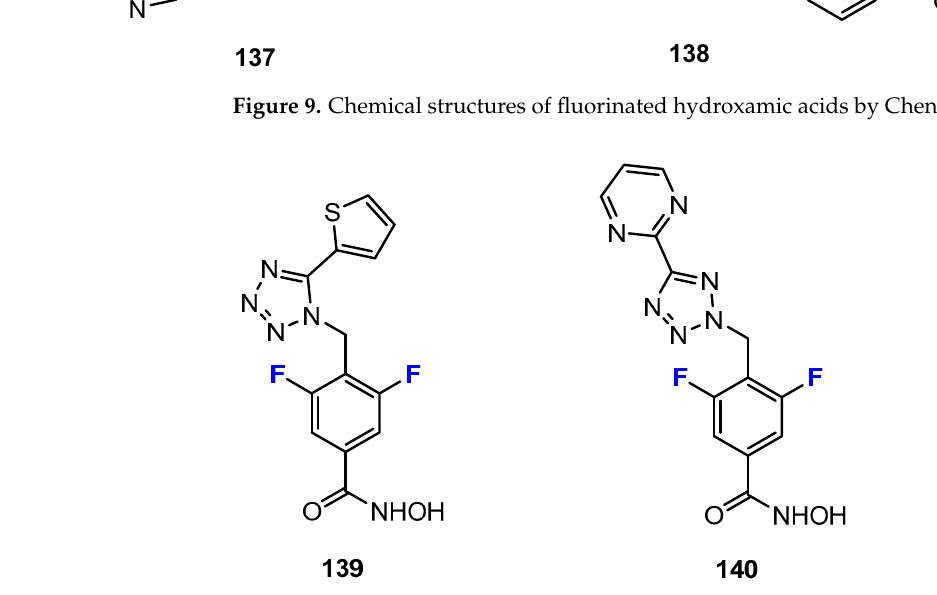
Figure 10. Chemical structure of fluorinated hydroxamic acids by Sandrone et al.